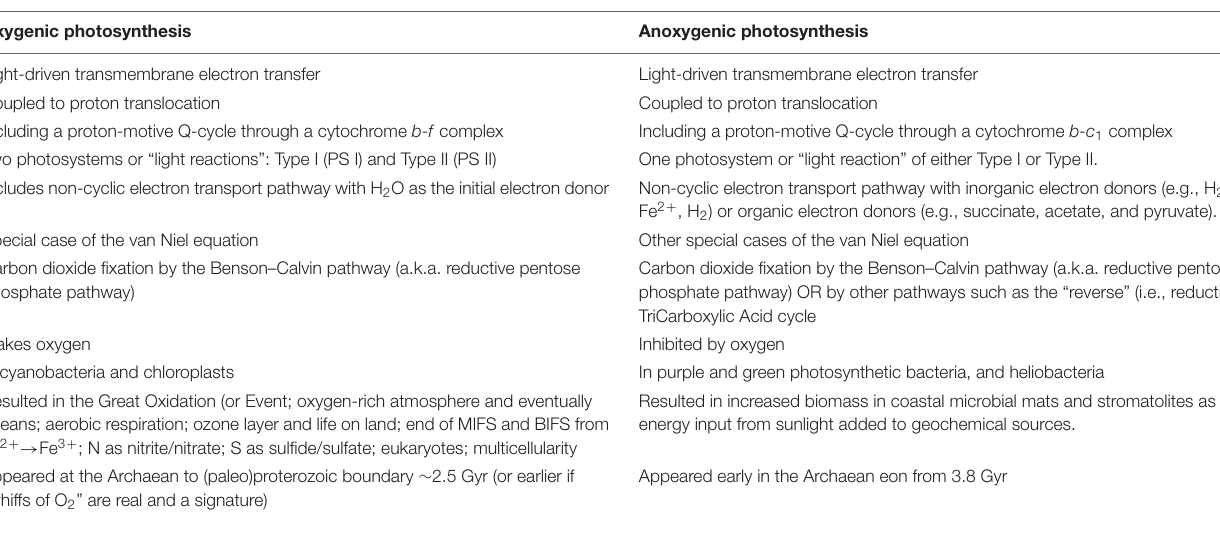
TABLE 1 | Characteristics of oxygenic and anoxygenic photosynthesis. Oxygenic